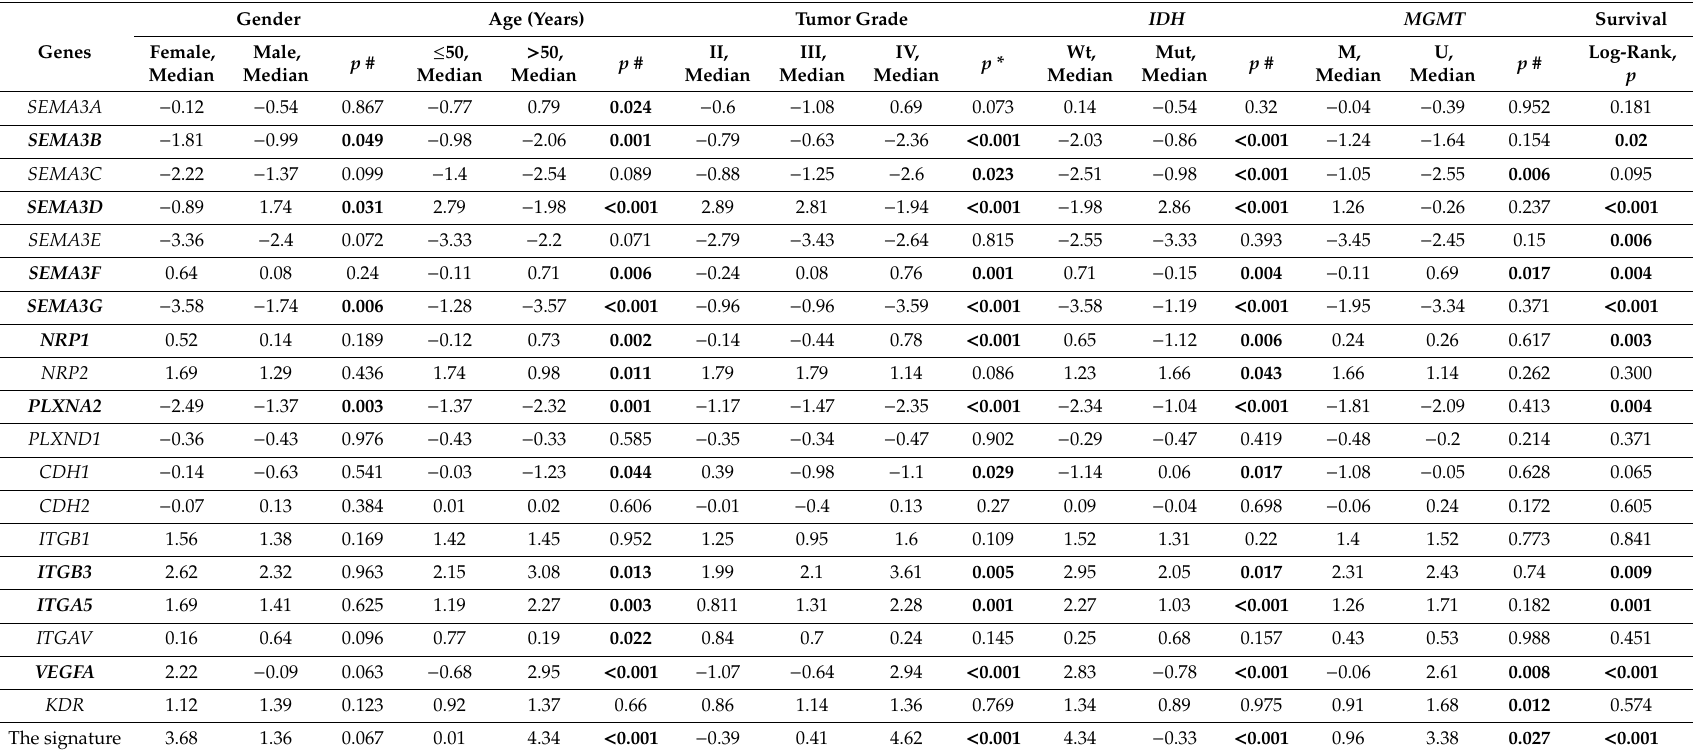
Table 1. Relationships between expression of SEMA3 genes and patient clinical